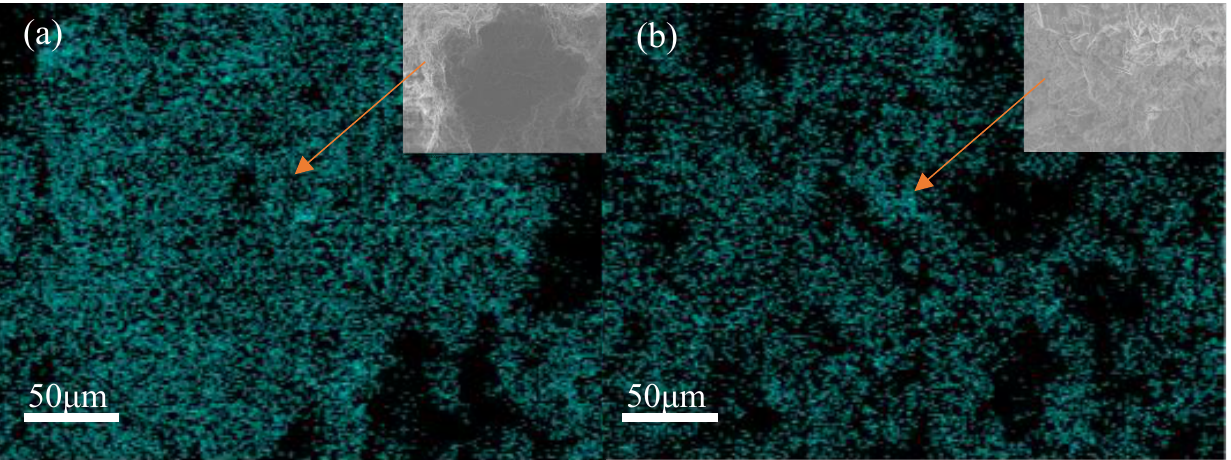
Figure 12. ( a ) The phosphorus mapping diagram of PB cured for 28 d; ( b ) the phosphorus mapping diagram of PBI-20 cured for 28